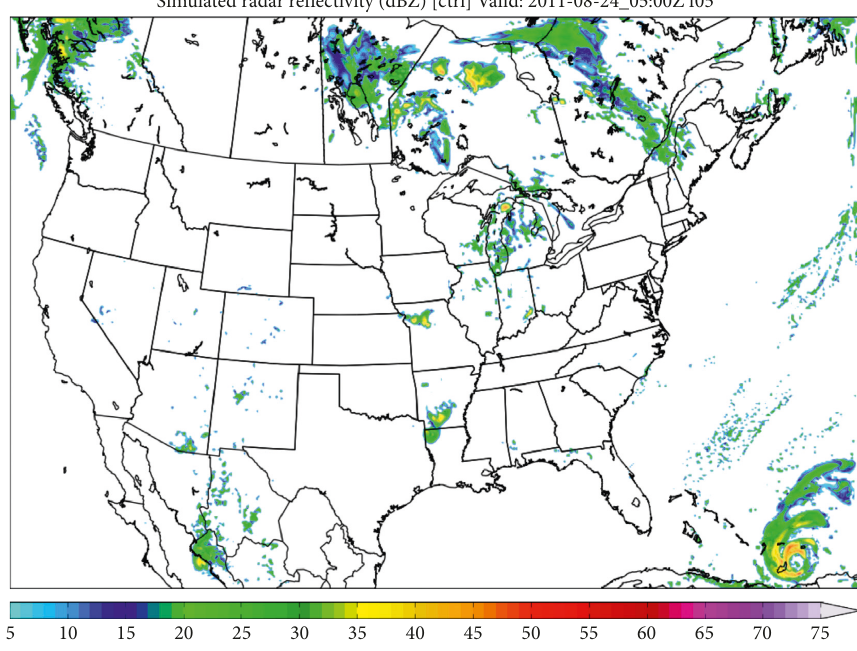
Figure 7: Simulated reflectivity at forecast hour 05 for the control